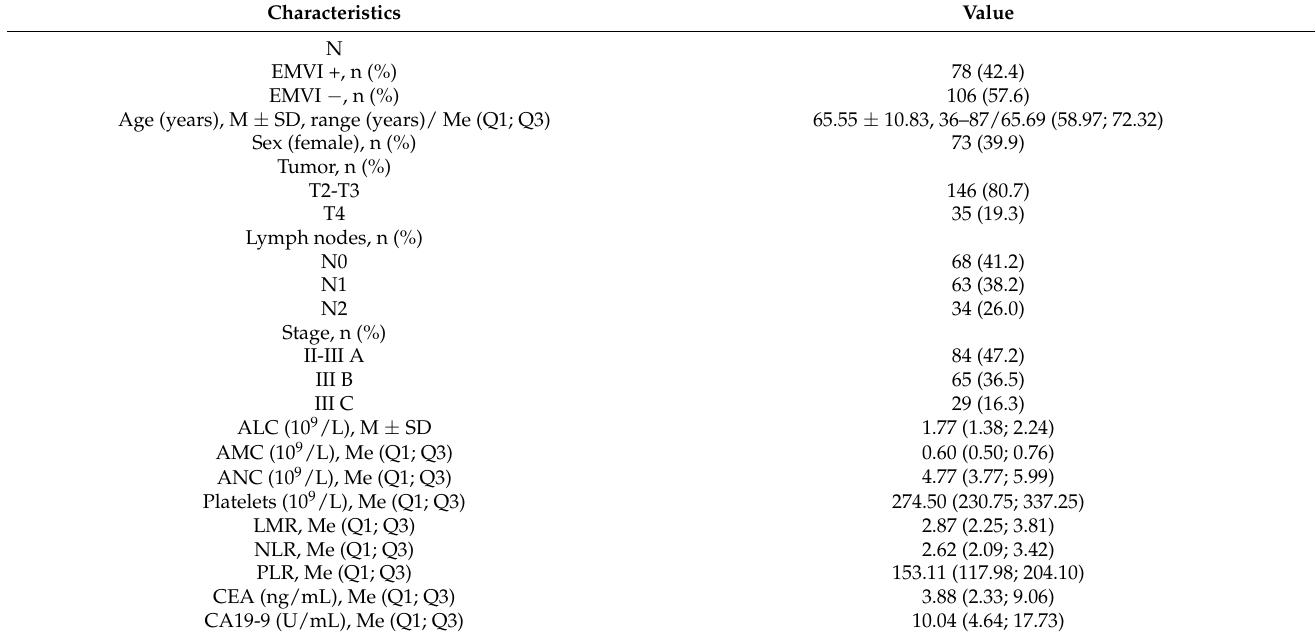
Table 2. Characteristics of all patients.